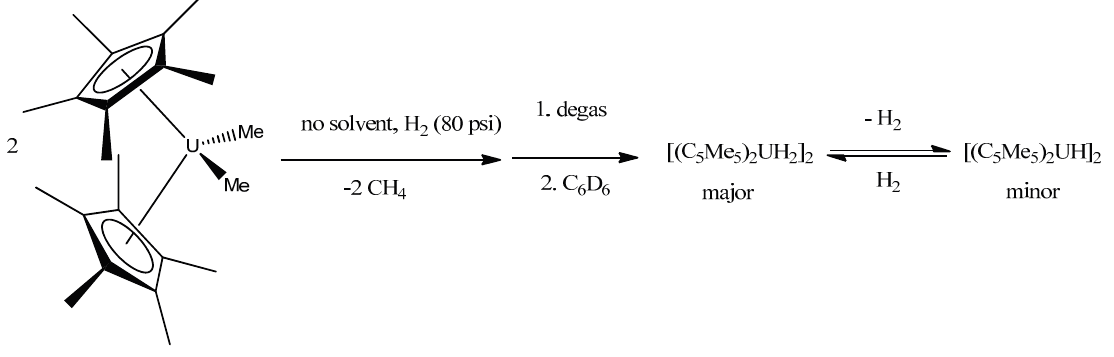
Me ) UMe with H 5 5 2 2